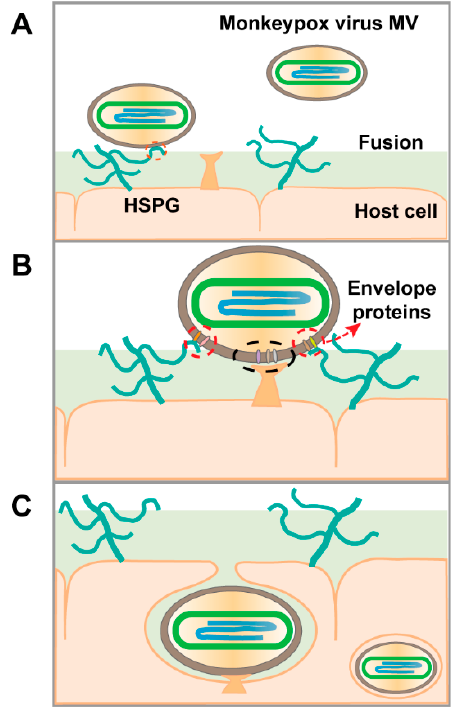
Figure 6. Proposed model of MPXV host-cell entry. ( A ) Virions land on the host-cell surface by binding to heparan sulfate proteoglycan (HSPG). ( B ) Then, host-cell surface protease s initiate viral- host-cell membrane fusion. ( C ) Finally, virions enter the host